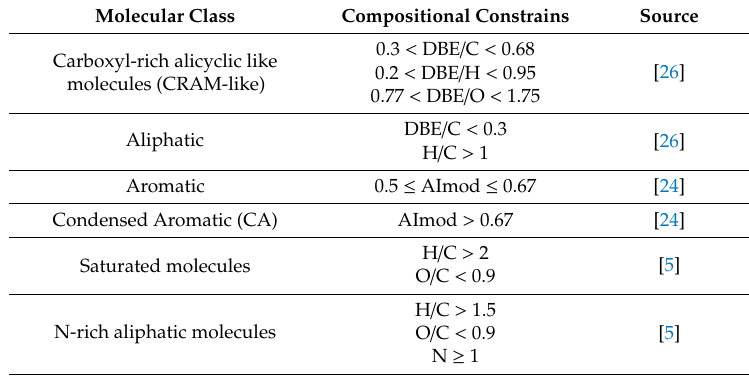
Table 1. Molecular categories adopted in this study for describing the molecular diversity of the solid phase extracted DOM